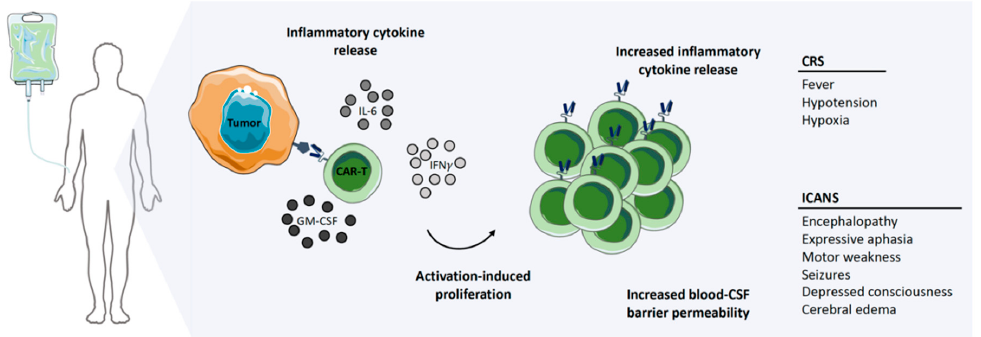
Figure 3. CAR-T cell treatment-related toxicities. Toxicities associated with the antigen-induced activation and proliferation of CAR-T cells caused by the release of cytokines. Abbreviations: IL-6, interleukin-6, IFN γ , interferon gamma; GM-CSF, granulocyte-macrophage colony-stimulating factor; CSF, cerebrospinal fluid; ICANS, immune effector cell-associated neurologic syndrome; CRS, cytokine release syndrome.